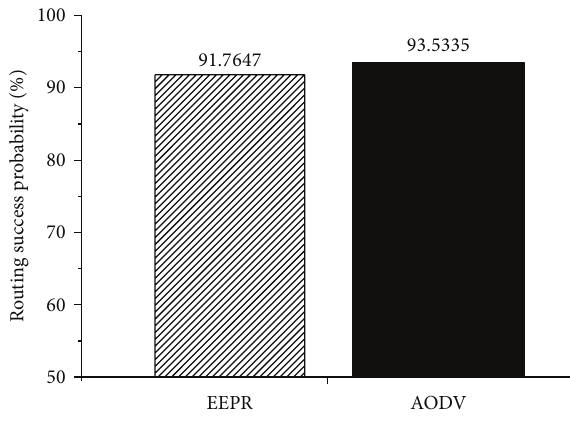
Figure 9: Routing success